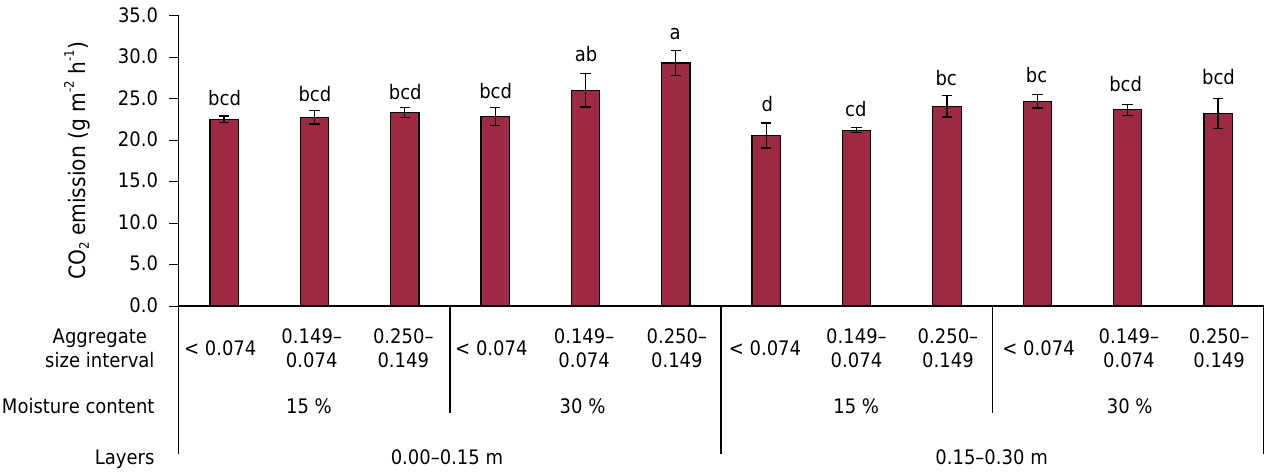
Figure 6. Accumulated emission of CO 2 by aggregate size, level of moisture and depth in a calcareous soil of the Comarca Lagunera,